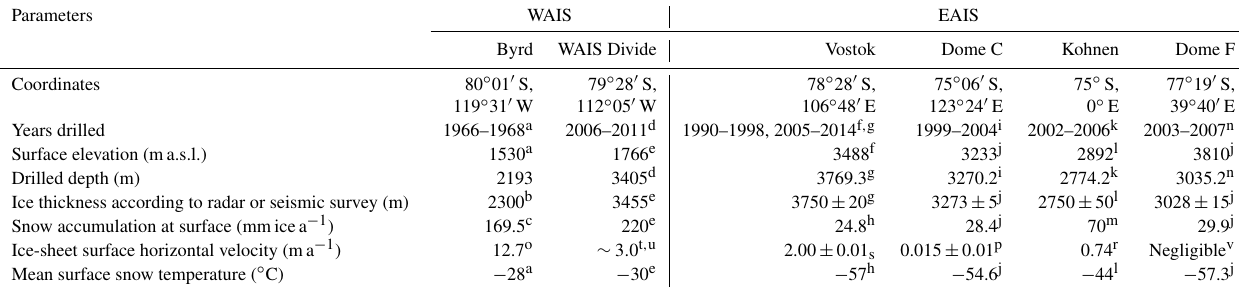
Table 1. Information for Antarctic deep-ice-drilling